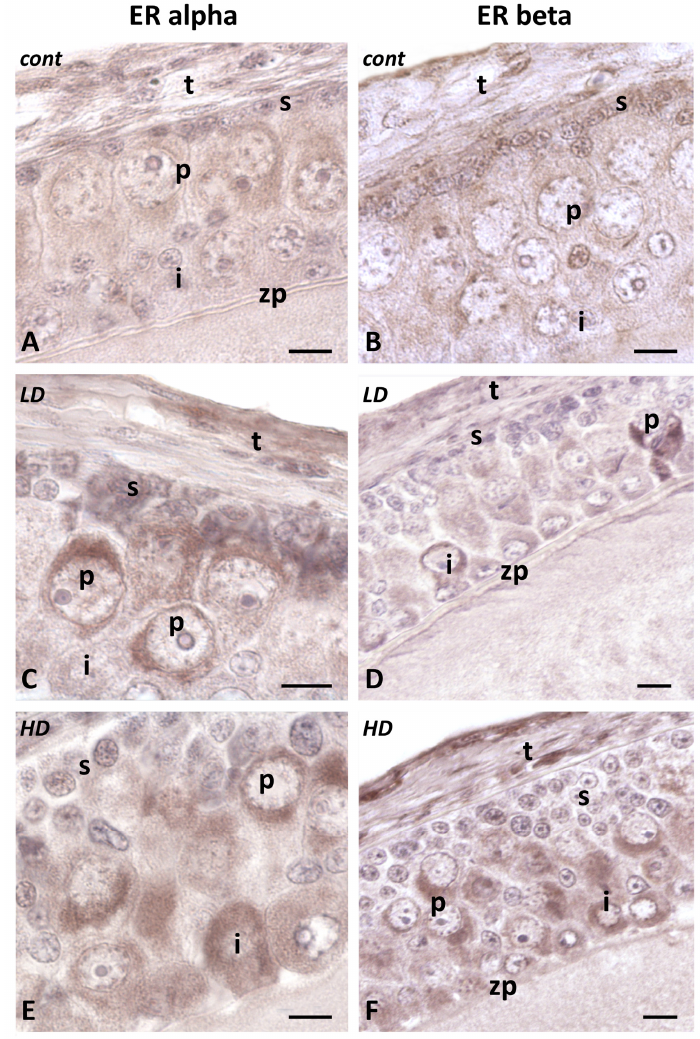
Figure 8. Immunohistochemical localization (brown areas) of ER α and ER β in follicles of P. siculus treated with low (LD) or high (HD) doses of glyphosate. ( A , B ) Weak signal on the epithelium. Small (s), intermediate (i), pyriform (p), and theca (t) cells. Zona pellucida (zp). ( C , D ) Appear- ance of an intense signal on the cytoplasm of occasional intermediate (i) and pyriform (p) cells. ( E , F ) Intensification of the signal on intermediate (i) and pyriform (p) cell cytoplasm. Stained theca cells (t), unstained small (s) cells, and zona pellucida (zp). Scale bars: 20 µ